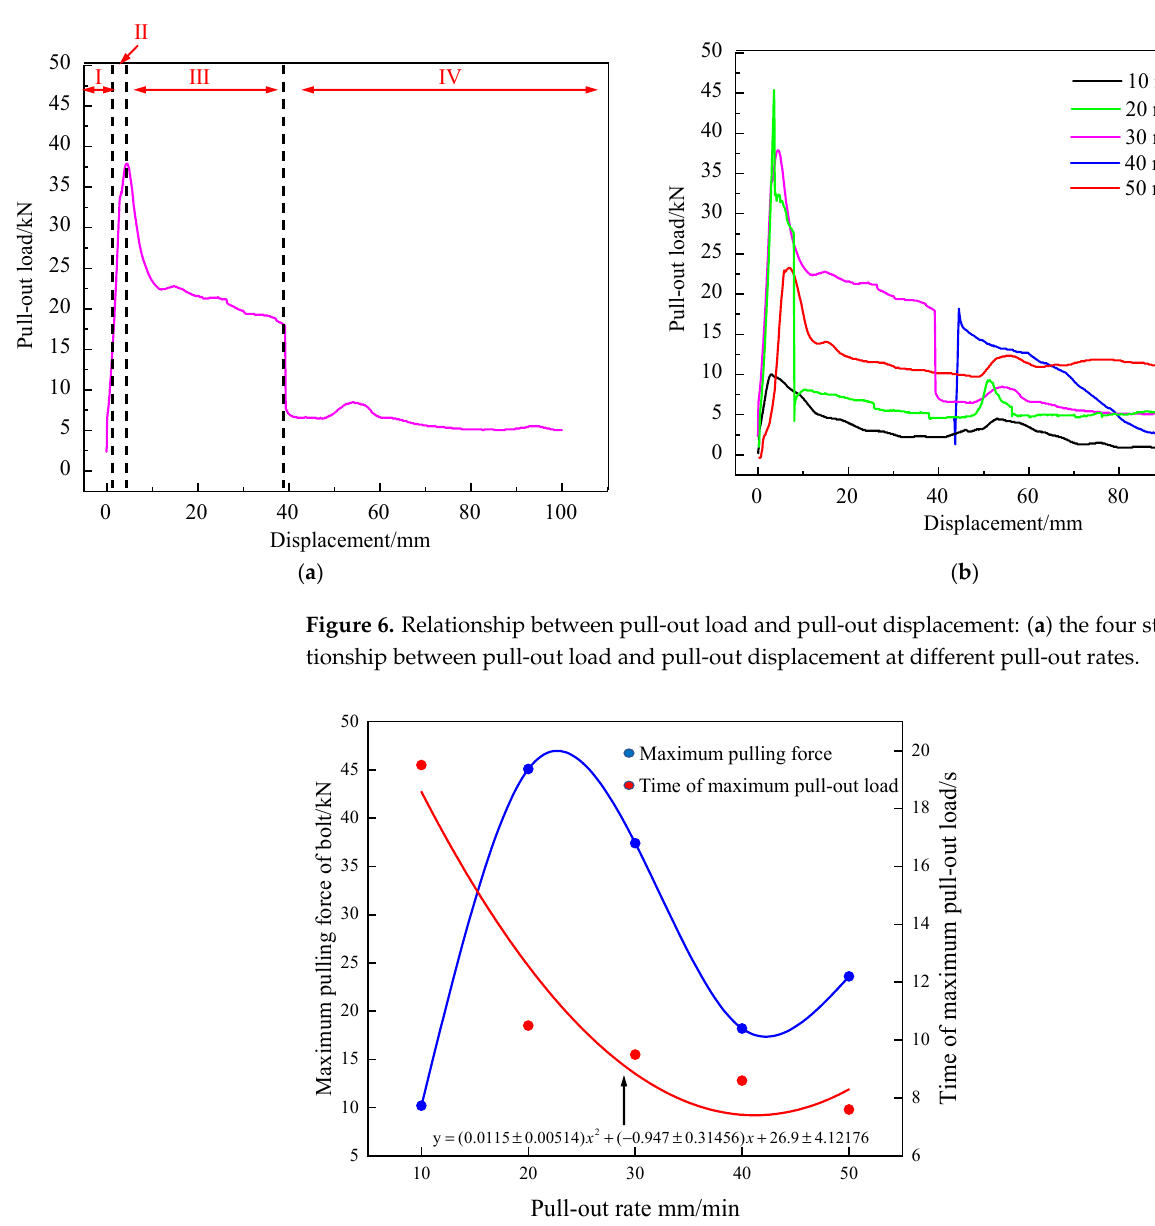
Figure 7. Relationship between maximum pull-out force and maximum pull-out load time under different drawing rates.